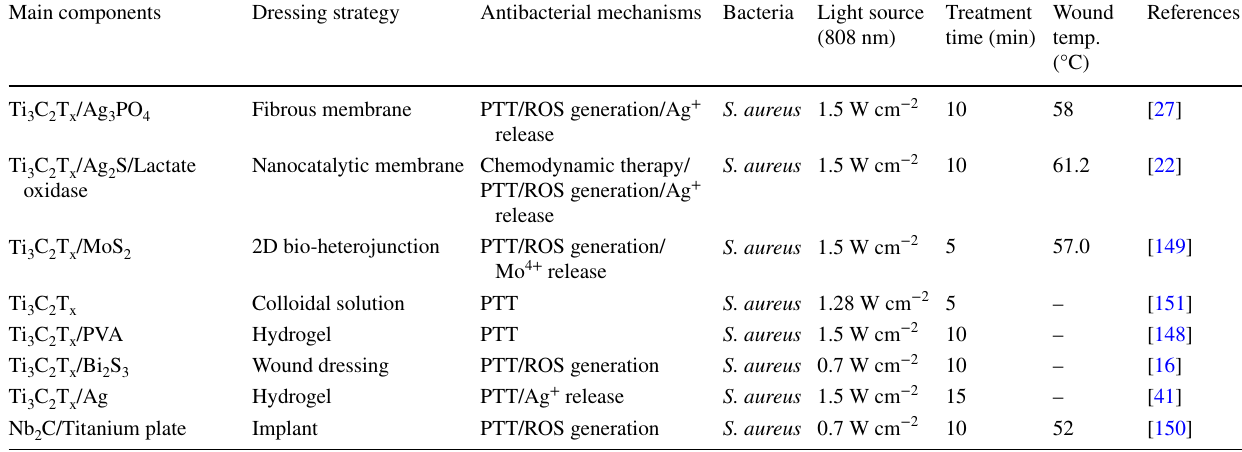
Table 4 Summary of in vivo photothermal-derived antibacterial applications using MXenes-based materials Main